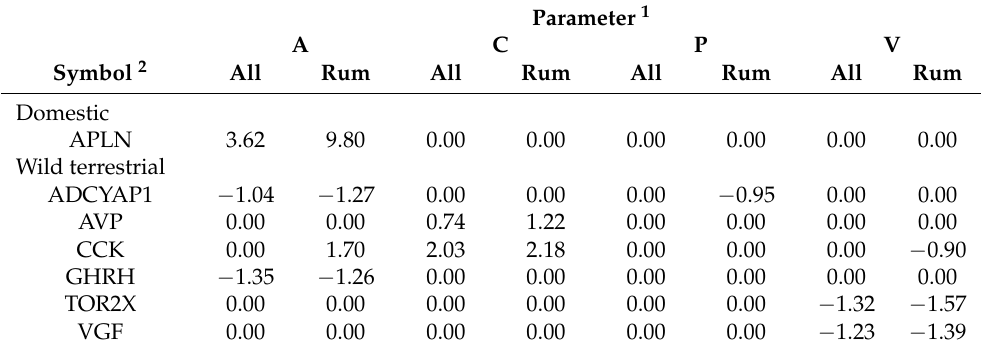
Table 3. Parameter estimates for neuropeptide prohormone genes that presented changes in domestic or wild